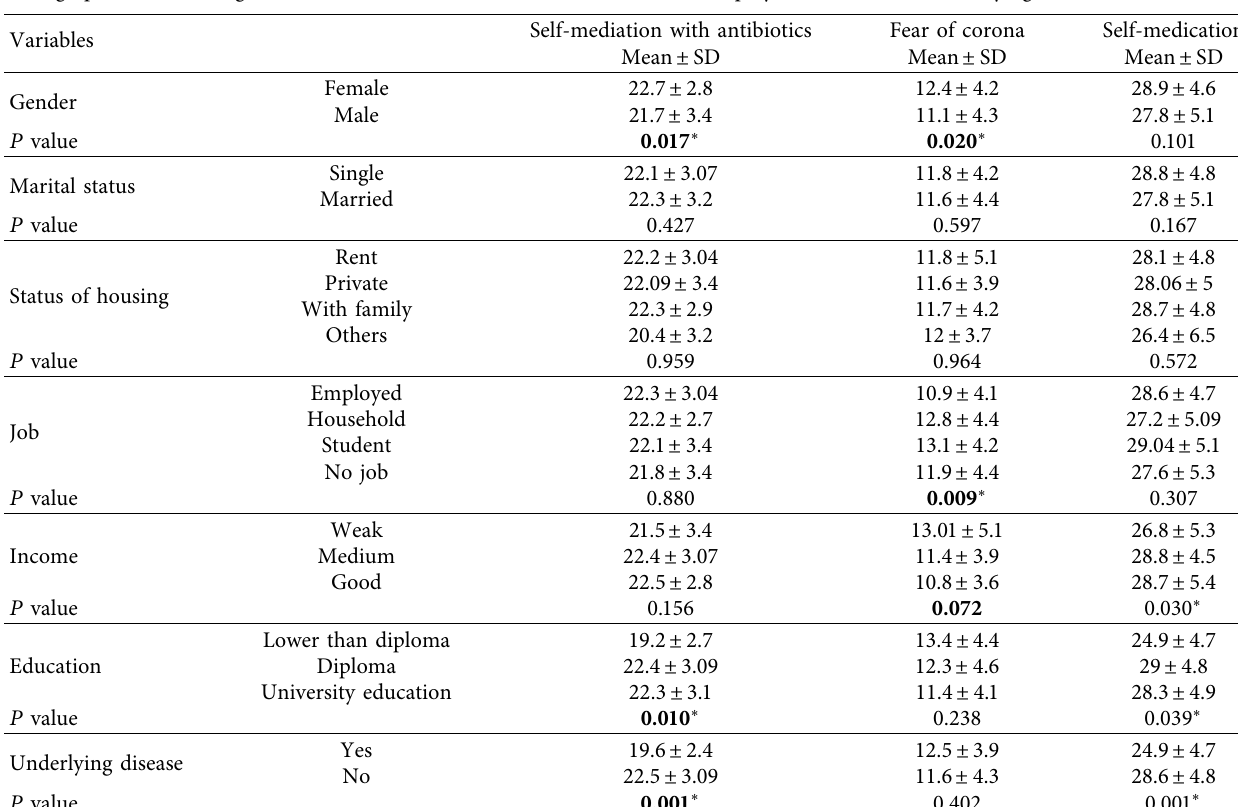
Table 6: Measuring the relationship between the three variables of corona fear, self-medication, and self-medication with antibiotics with demographic variables (age, sex, marital status, economic status, education, employment status, and underlying disease).